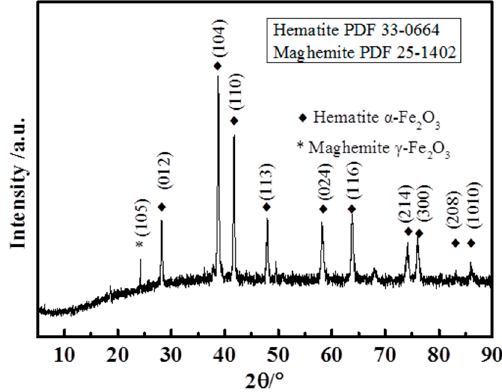
Figure 1. The schematic illustration of the synthesis process of graphene-Fe 2 O 3 sheet. The XRD measurement is used to ascertain the crystallographic phases of the prod- ucts. The XRD pattern of the graphene-Fe 2 O 3 sheet is shown in Figure 2. The diffraction peaks located at 2 θ = 28.63°, 38.89°, 42.02°, 48.30°, 58.29°, 63.99°, 74.26°, 76.55°, 83.39°, and 86.52° can correspond to (012), (104), (110), (113), (024), (116), (214), (300), (208), and (1010) planes of the α -Fe 2 O 3 (JCPDS 33-0664). Meanwhile, the diffraction peaks located at 2 θ = 24.06° can correspond to (105) planes of the γ -Fe 2 O 3 (JCPDS 25-1402). Therefore, both maghemite γ -Fe 2 O 3 and hematite α -Fe 2 O 3 crystal structures coexist in the products. The sharp diffraction peaks indicate the good crystallization of Fe 2 O 3 during the hydrothermal process, and there is no obvious impurity [25].